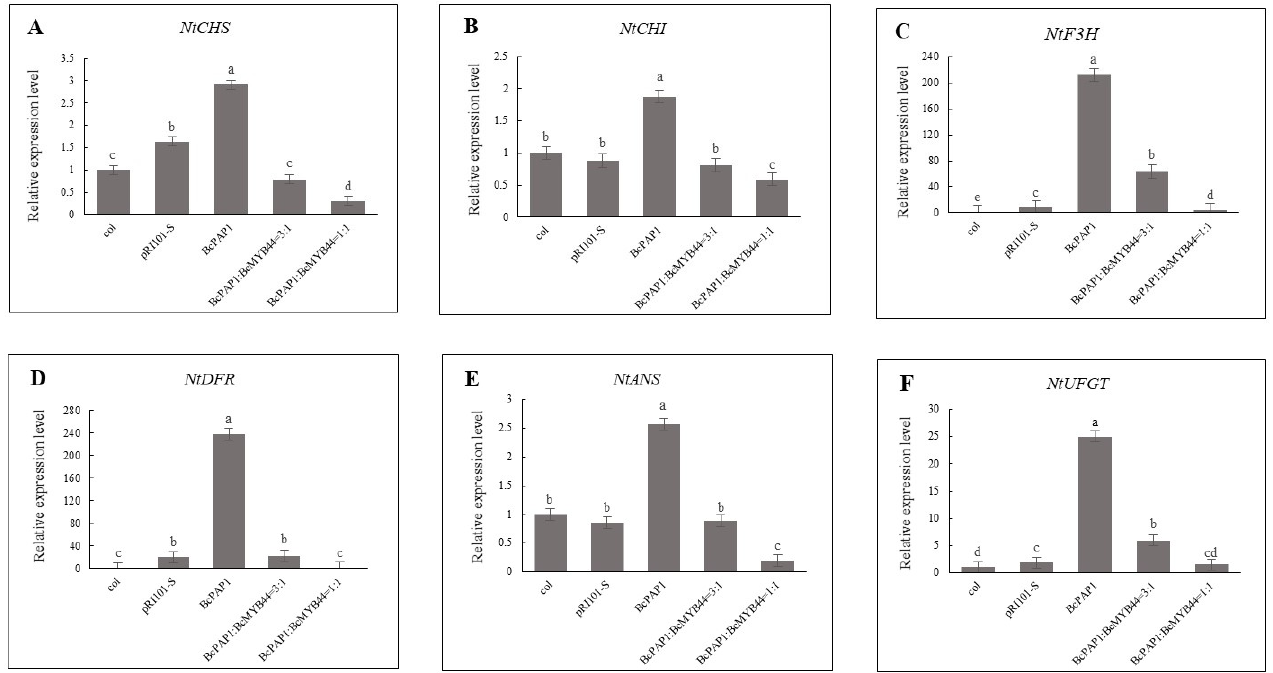
Figure 6. Relative expression levels of key structural genes for anthocyanin synthesis in N. benthamiana. ( A — NtCHS ; B — NtCHI ; C — NtF3H ; D — NtDFR ; E — NtANS ; F — NtUFGT ). Note: Different lowercase letters indicate significant difference ( p < 0.05).